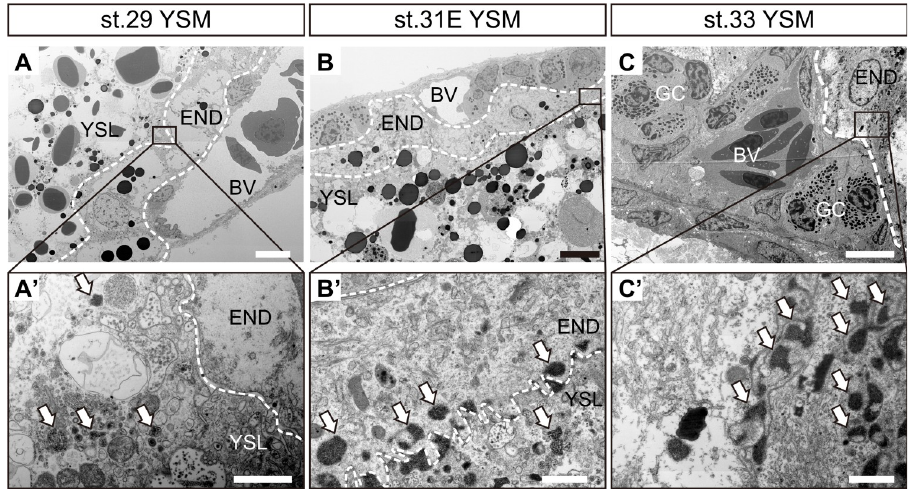
Fig 7. Electron microscopic ultrastructural observations on the developing yolk sac membrane. (A-C) Ultrastructure of the boundary between yolk contents and epithelial cells of the YSM in different developmental stages. (A’-C’) Small boxes in panels A-C are magnified to show the fine structures. Arrows indicate membrane packets containing yolk granules. BV, blood vessels; END, endodermal cells; GC, granular cells; YSL, yolk syncytial layer. Bars, 10 μ m (A-C), 1 μ m